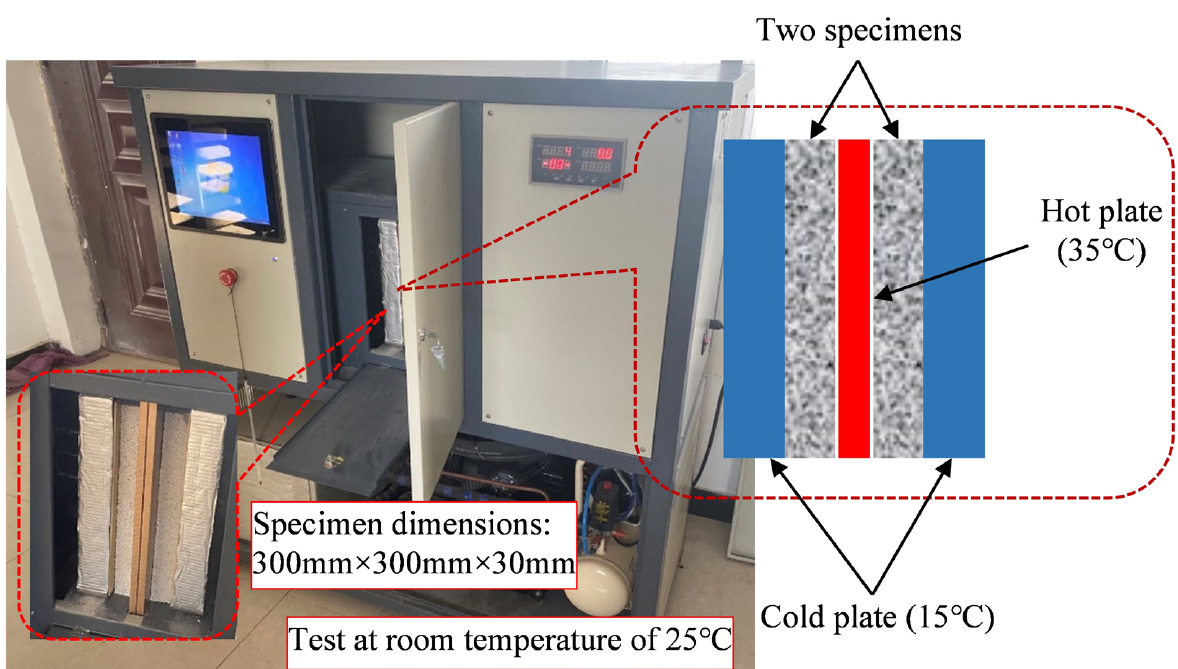
Figure 3. The instrument and specimens for thermal conductivity test.